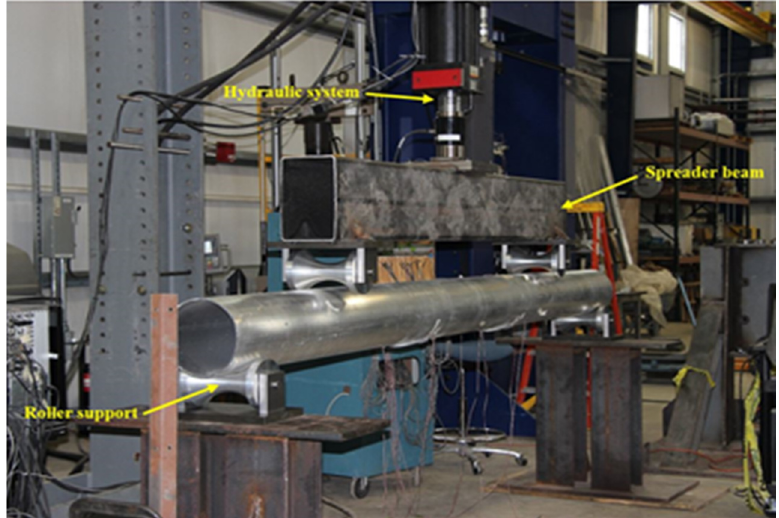
Figure 3. Four point bending fatigue test set-up.